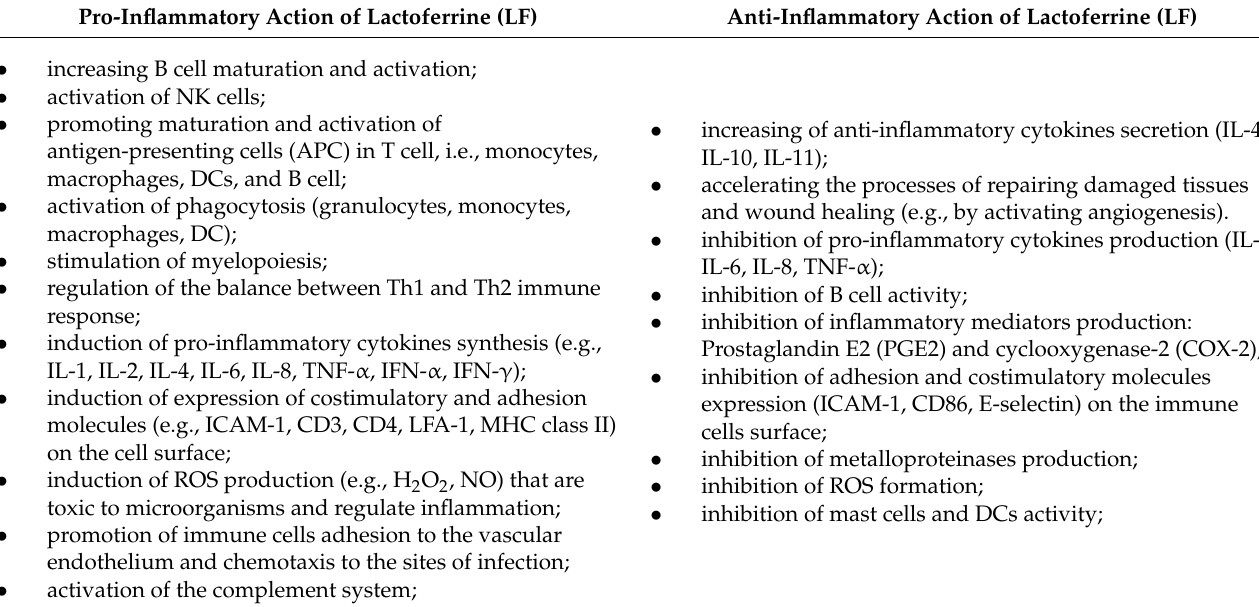
Table 2. Pro-inflammatory and anti-inflammatory action of